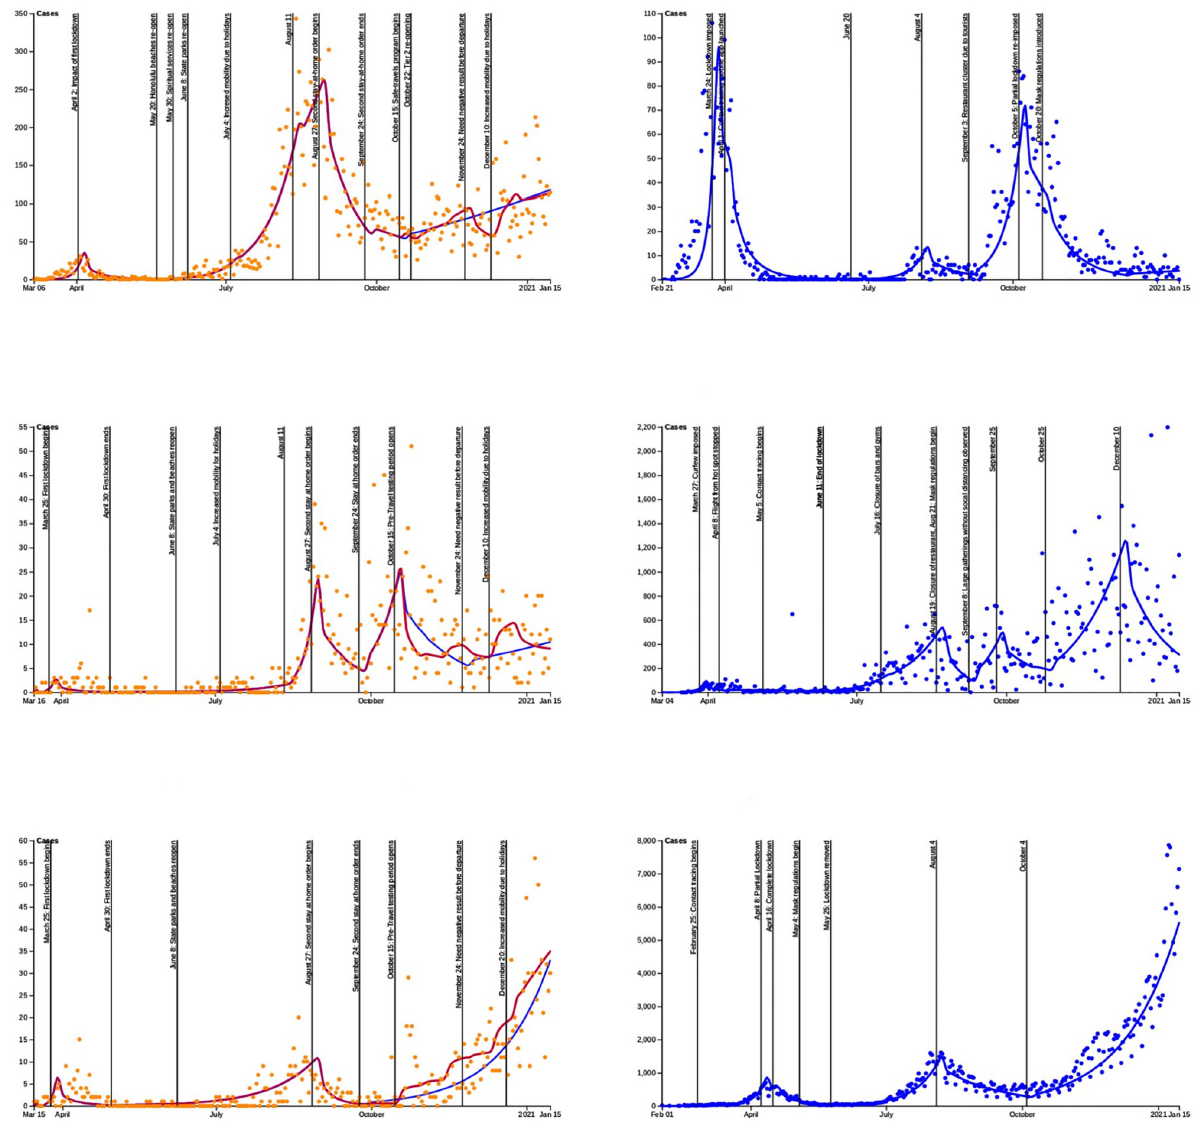
Fig 11. Comparison between the daily cases between Hawai‘i counties and other geo-regions. A: Honolulu County and Iceland. B. Hawai‘i County and Puerto-Rico. C: Maui county and Japan. Dots are daily cases and the curves are the computational fit using our compartmentalized model. The blue fit for the Hawai‘i counties starting October 15, 2020 corresponds to not taking into account the travelers.